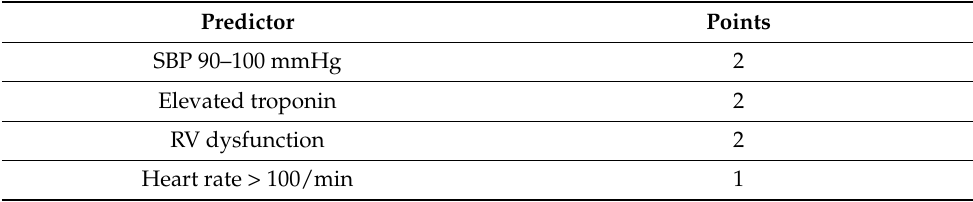
Table 4. Components of the Bova score.